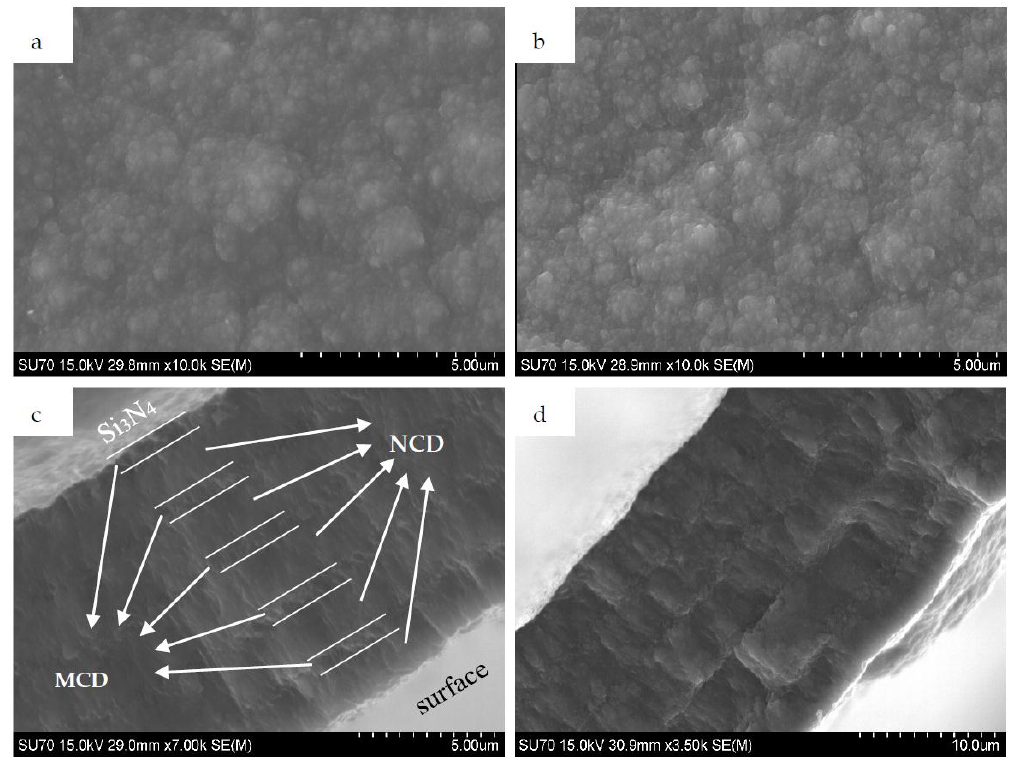
Figure 2. Representative SEM micrographs of the surfaces of ( a ) ML10x1 and ( b ) ML10x2 inserts and respective cross sections in ( c ) and ( d ) (notice the scale difference in the bottom pictures).